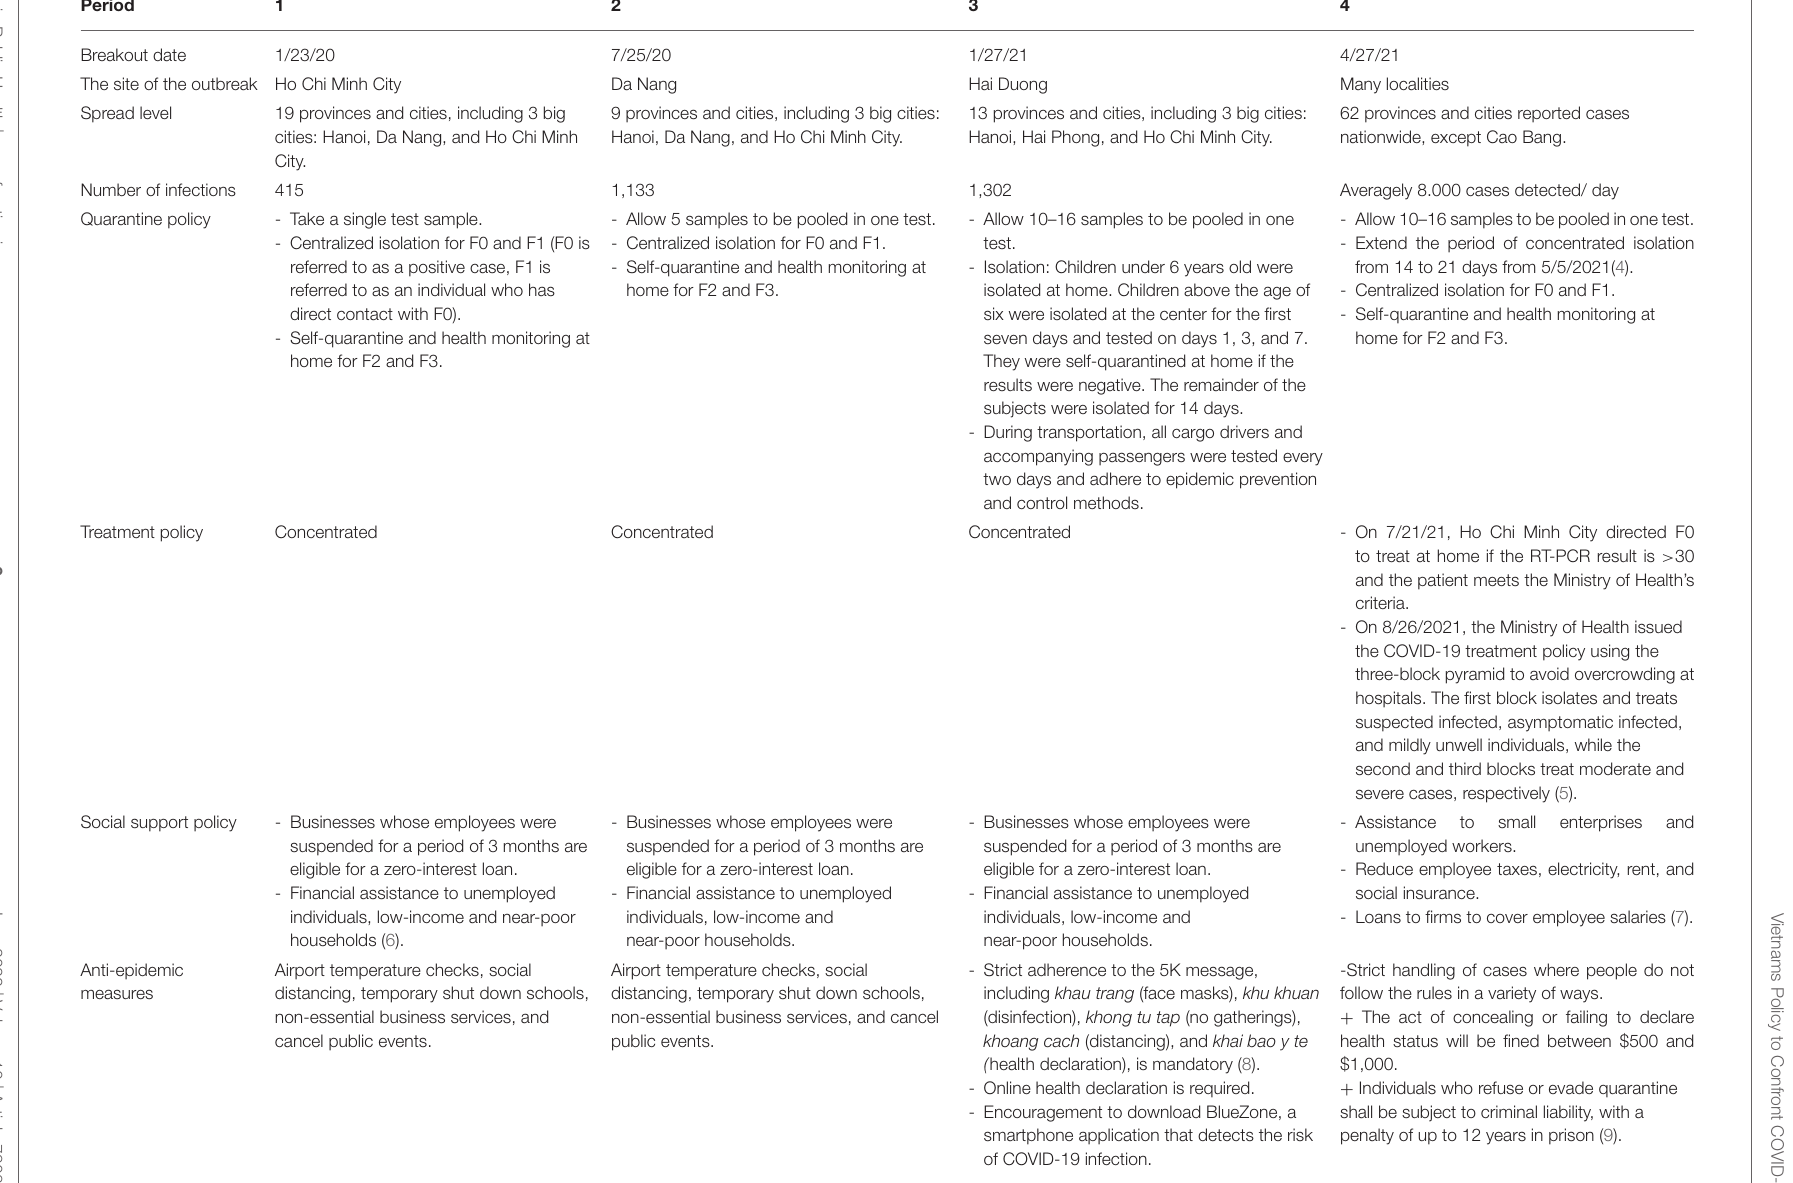
TABLE 1 | The variations in each COVID-19 reemergence’s characteristics and policies implemented by Vietnam. Period